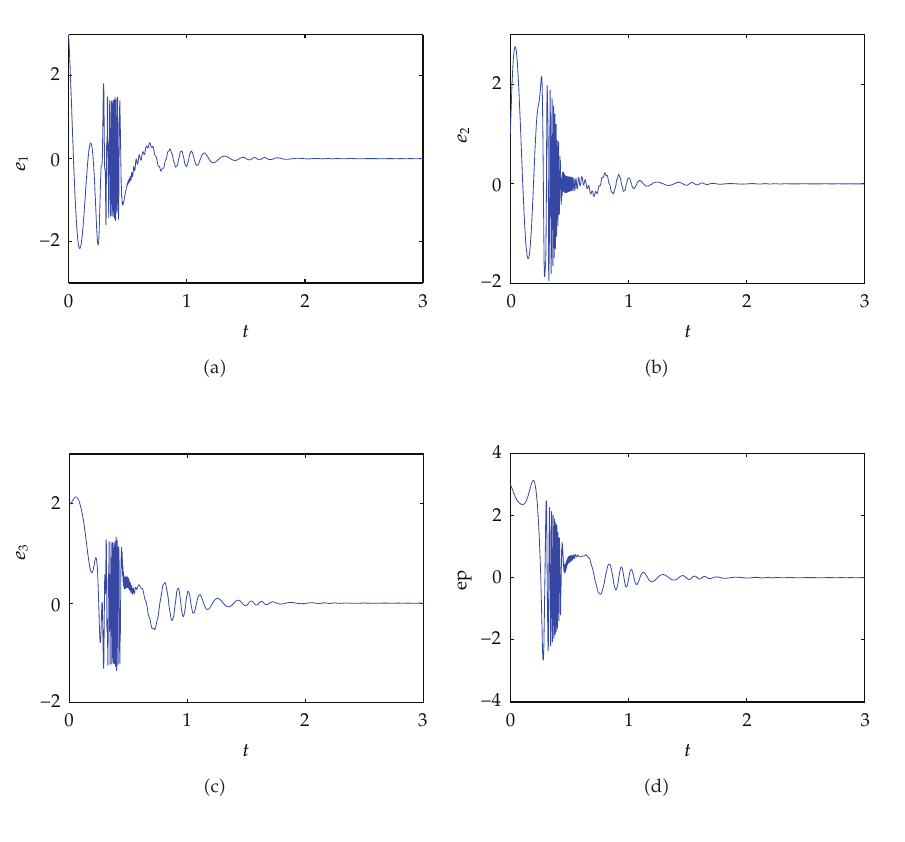
Figure 2: Time evolution of the AHFPS error.